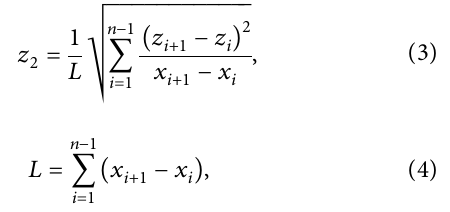
Figure 3: Characteristic parameter of the 2D profile